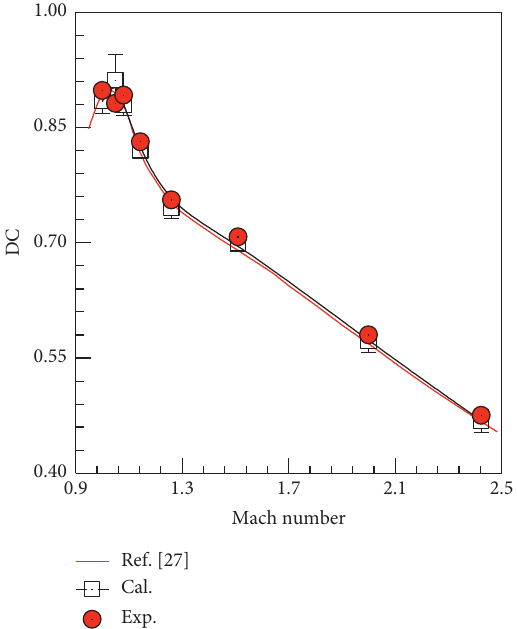
Figure 5: Comparison of DC between simulation and